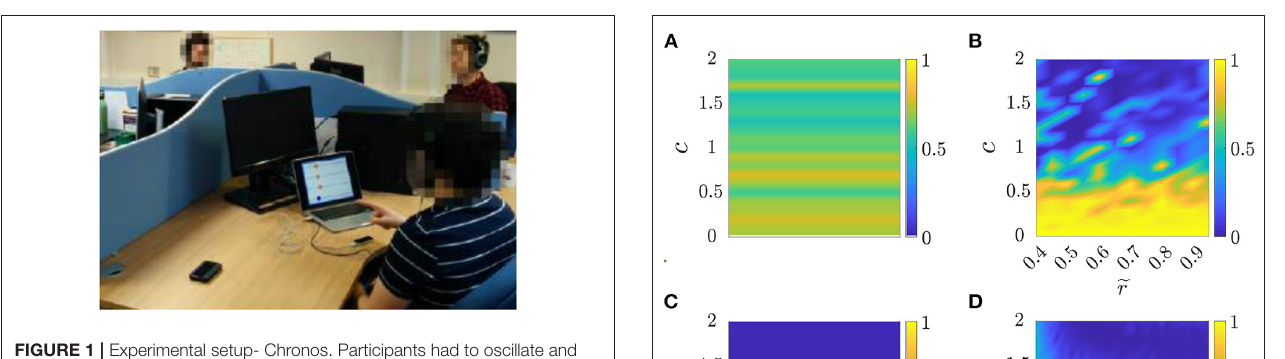
FIGURE 1 | Experimental setup- Chronos. Participants had to oscillate and synchronize the index finger of their preferred hand over a Leap Motion controller while being virtually connected with the others through the platform Chronos.